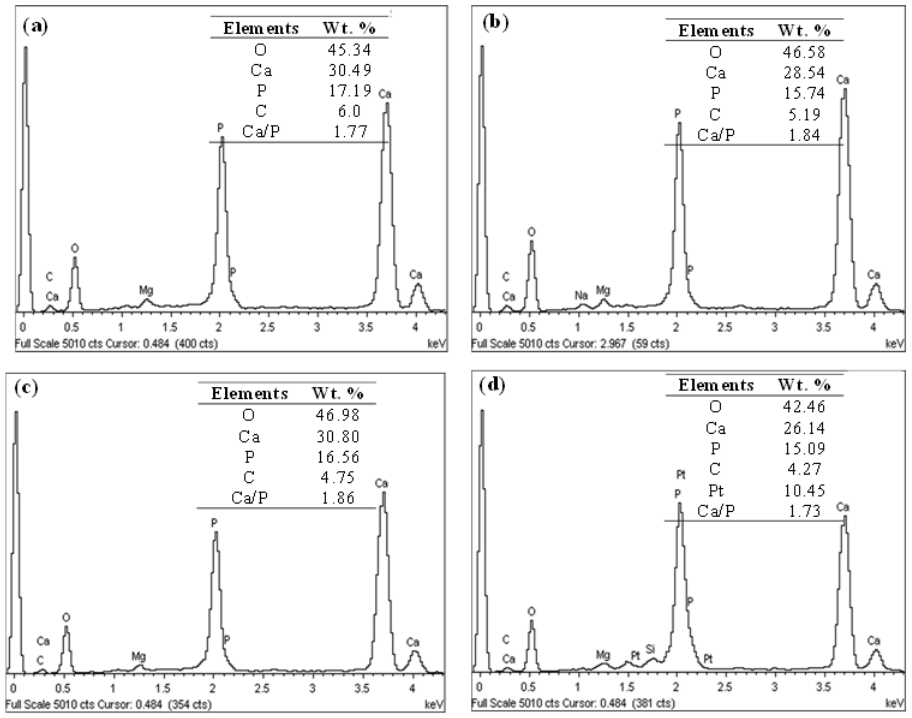
Figure 11. EDX analysis of plasma-sprayed FsHA with ( a ) 0 wt.% YSZ, ( b ) 10 wt.% YSZ, ( c ) 15 wt.% YSZ, and ( d ) 20 wt.% YSZ coatings on the Ti–6Al–4V substrate after 14 days of immersion in SBF.